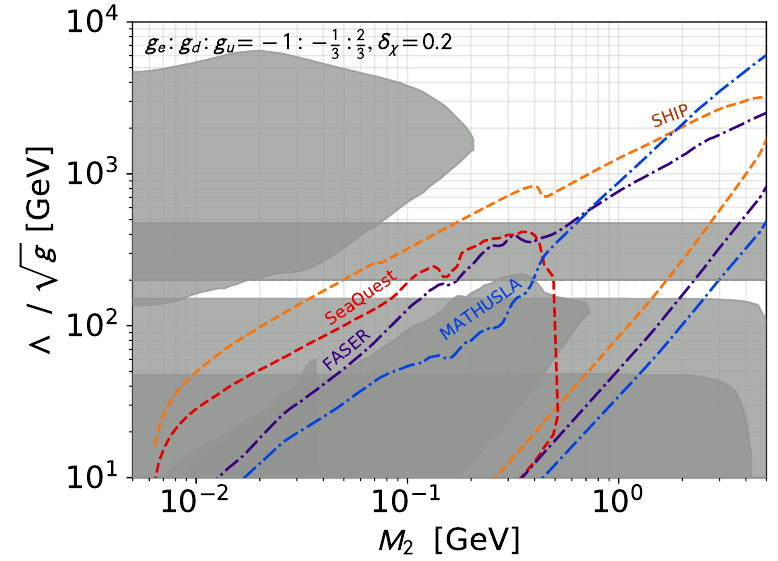
Figure 6 . Prospective sensitivity at future intensity frontier experiments on the vector operator p e(cid:11)ective scale (cid:3) = g in the case of electromagnetically-aligned e(cid:11)ective couplings as a function of M 2 on the x-axis for (cid:14) (cid:31) = 0 : 2 (de(cid:12)ned in eq. (2.4)). Grey areas indicate already covered parameter space. We show prospects for FASER [66] in dashed purple and SeaQuest in red (Phase-II de(cid:12)ned in [34]), MATHUSLA [66] in blue and SHiP in green (based on our 10 events projections).